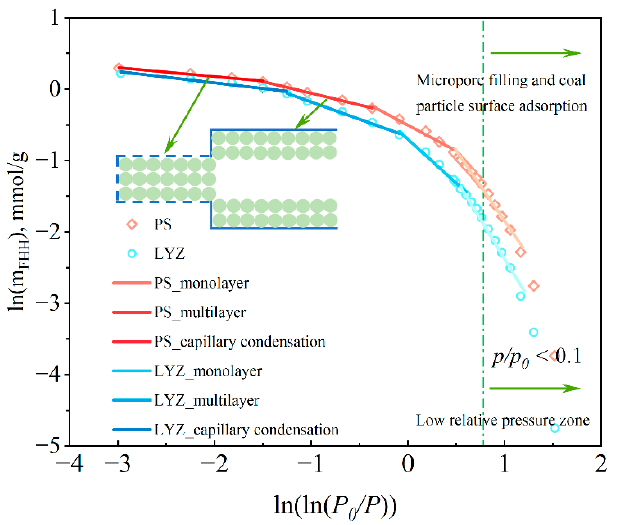
Figure 6. The linear effect of PS and LYZ coal samples’ adsorbed water vapor data processed by the FHH model. Table 2. FHH Modeling Parameters of Adsorption Isotherms of PS and LYZ coal samples.